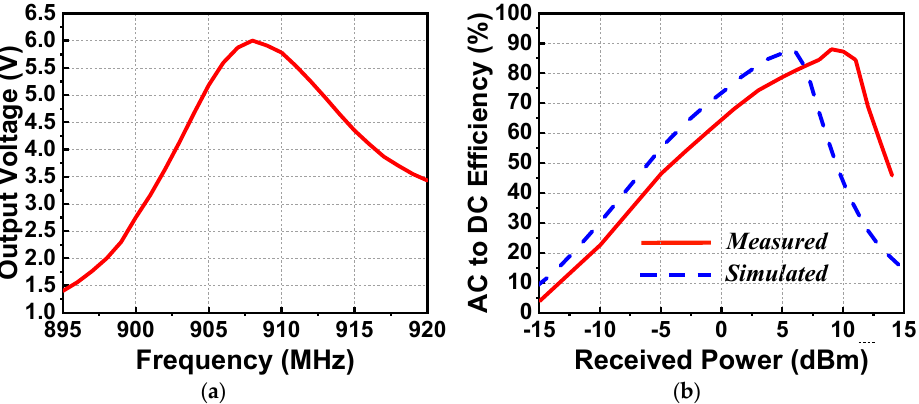
Figure 11. Measured results. ( a ) Output DC voltage as a function of the source frequency. ( b ) Output DC voltage and AC-to-DC conversion efficiency as functions of the received wireless power.